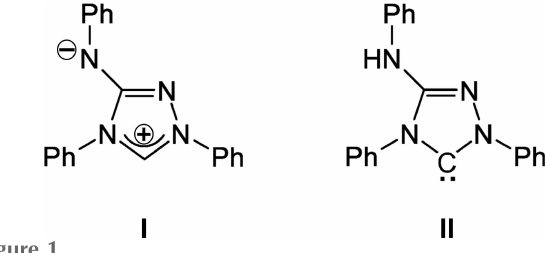
Figure 1 Structure of zwitterionic Nitron ( I ), and of its NHC-carbene tautomer ( II